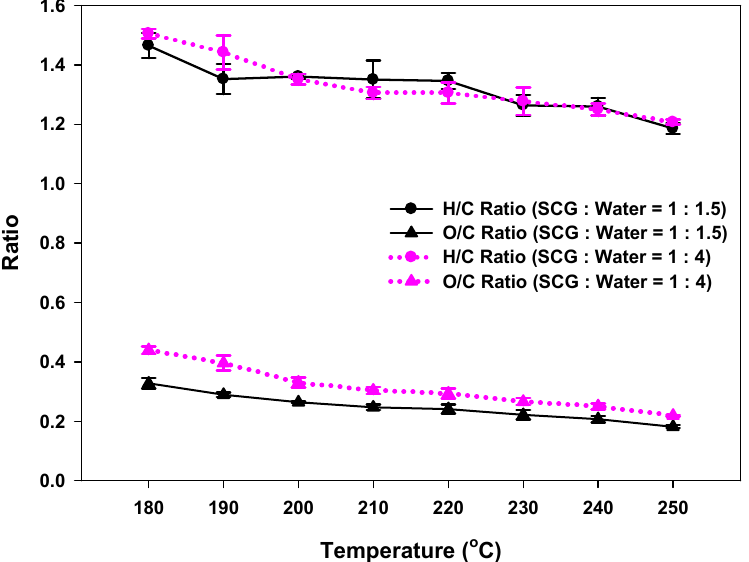
Figure 7. O/C and H/C ratios of SCGs hydrothermally carbonized with different reaction tempera- tures and water contents.